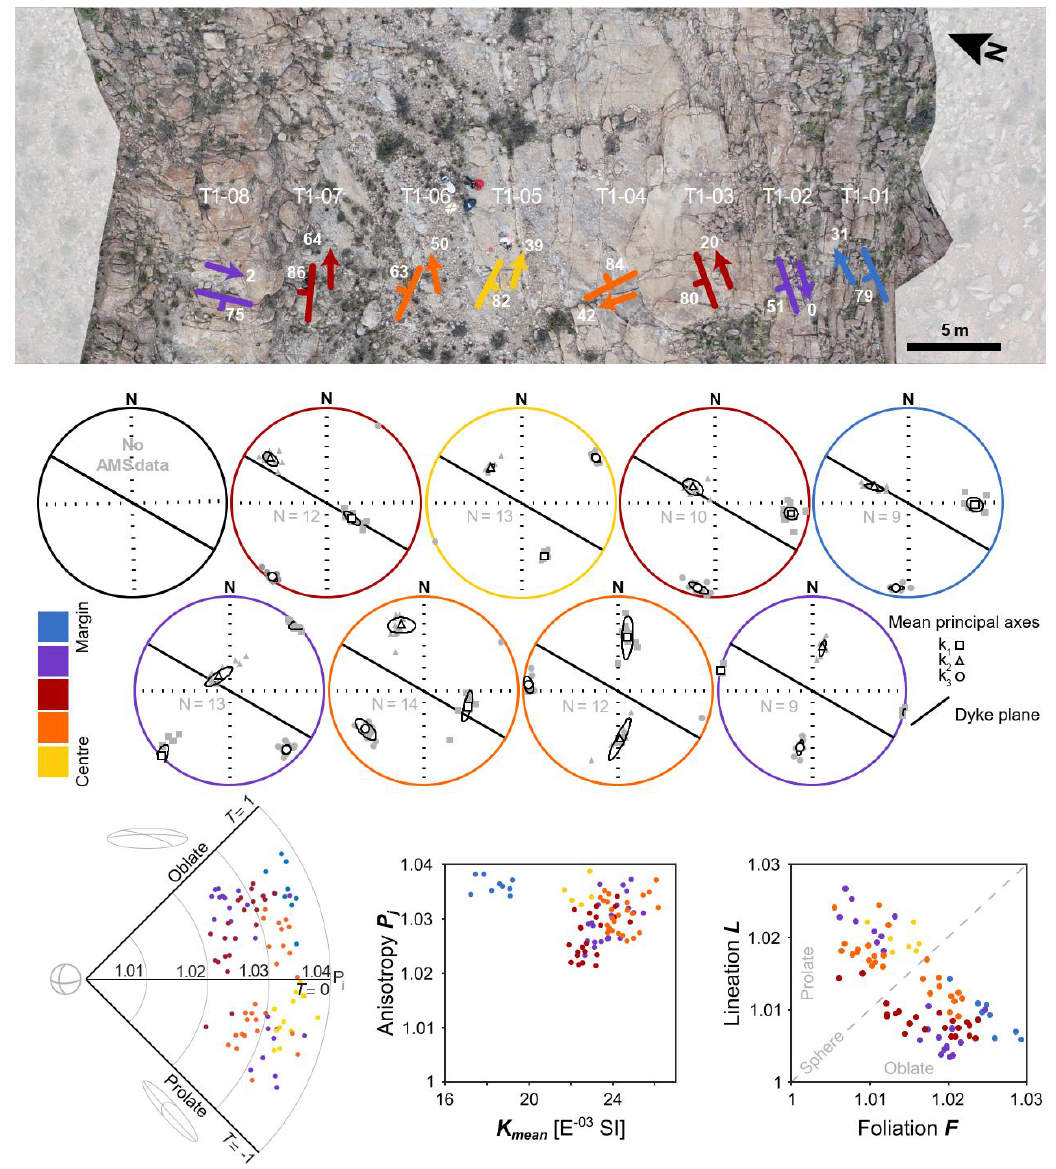
Figure 6. Sosa Dyke – Traverse T1 ipAMS. (Top row) Sample location of T1 across the Sosa Dyke (Figure 2), where the same sample locations were used for whole rock geochemistry samples (Table A1); Magnetic lineation (Arrows); Magnetic foliation (strike-dip symbols). (Middle row) ipAMS data; contour shows 95% Jelinek confidence ellipse of mean principle tensor. (Lower row) ipAMS shape parameter plots. Samples from across the dyke displays varied fabric shapes, both transitional prolate and oblate. The AMS fabrics are oriented obliquely relative to the dyke margin. In the SW half of the dyke the foliation fabrics are dominantly oriented E-W. In the NE half of the dyke sample foliations dominantly strike NW-SE.